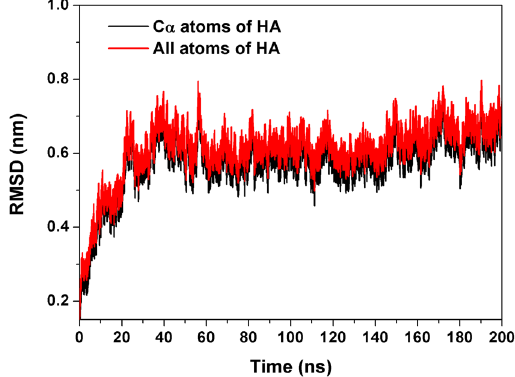
Figure 3. RMSD plot during molecular dynamics simulations.